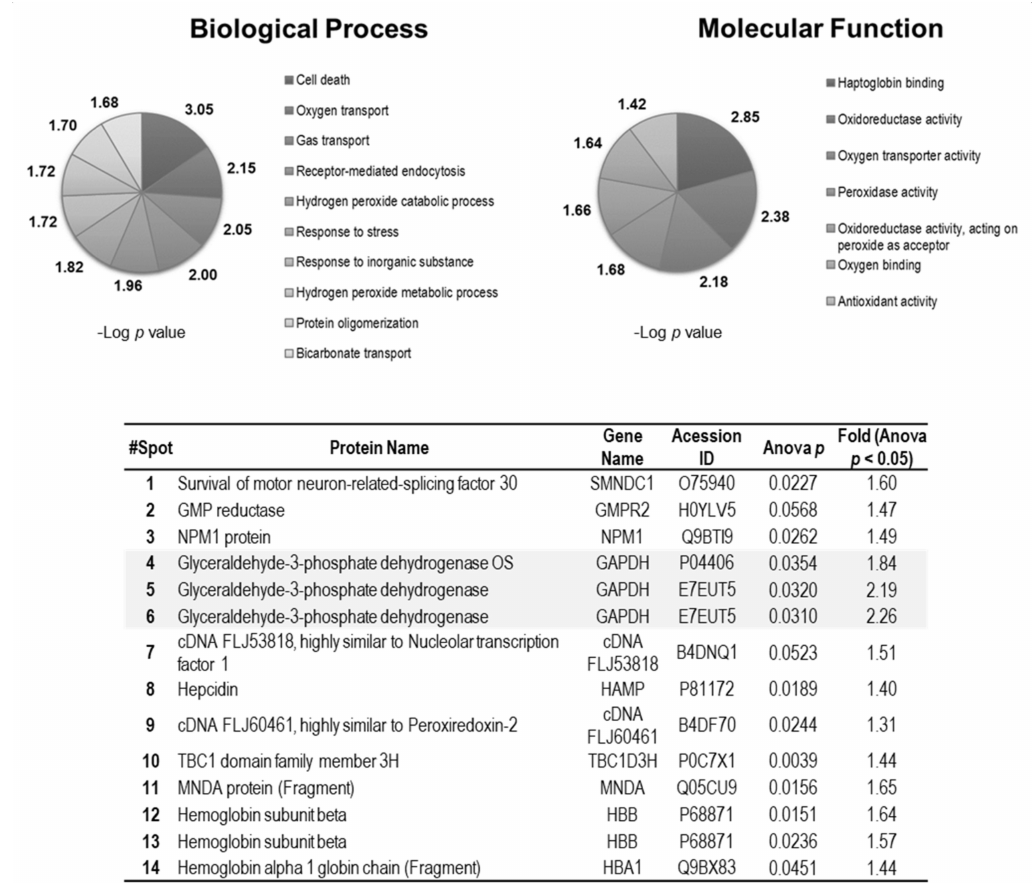
Figure 2. Biological processes and molecular functions of the most significantly changed proteins among Snorers and OSA before and after PAP treatment. Table at the bottom shows the list of proteins / proteoforms identified di ff erentially abundant among Snorers and OSA before and after six month of PAP treatment (fold change ≥ 1.2; Anova p < 0.05). The biological processes and molecular functions associated with these proteins acquired from Database for Annotation, Visualization and Integrated Discovery (DAVID) v6.8 are shown at the top of the